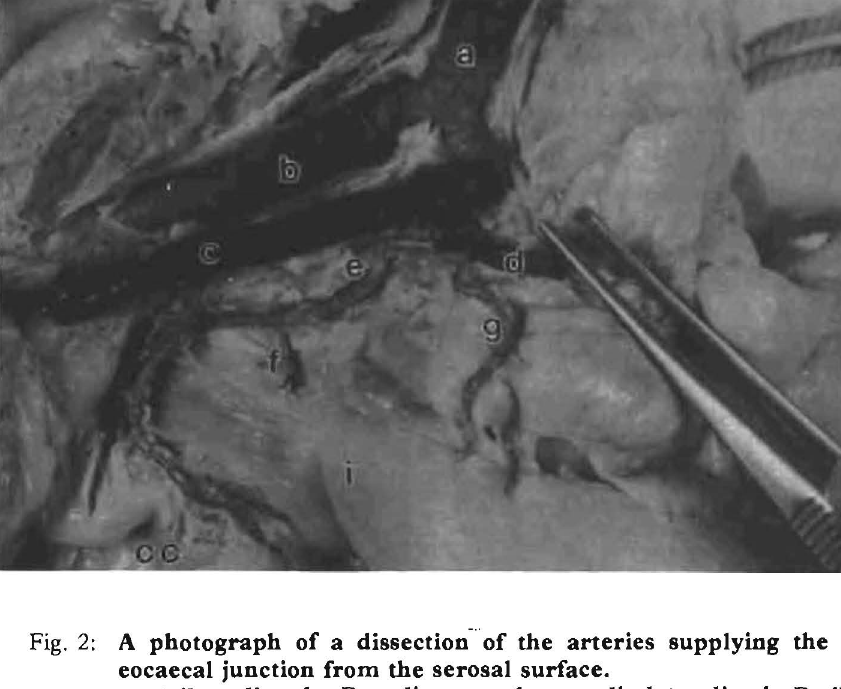
Fig. 2: A photograph of a dissection' of the arteries supplying the il eo caecal junction from the serosal surface.